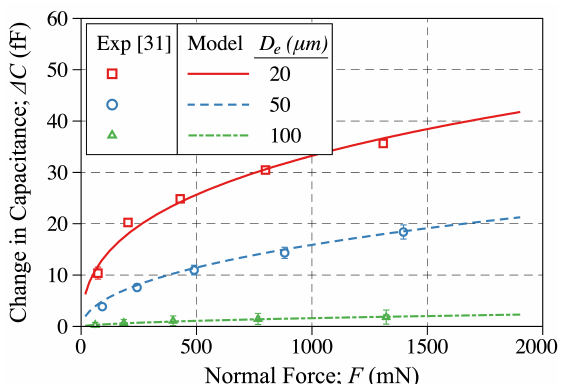
Figure 12. The change-in-capacitance plotted against the applied force. The discrete points are showing the experimental measurements reported in [31], while the solid line is showing the modeling results obtained in this study. The model predictions are reported for q = 2.52,2.10,0.42 and γ = − 0.27, − 0.07,0.13 for electrode gaps of D e = 20,50, and 100 µm,